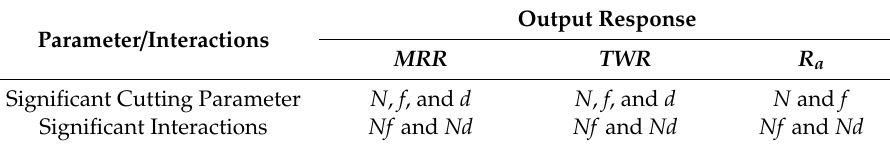
Table 9. Significant cutting parameters and their interactions for MRR , TWR and R a